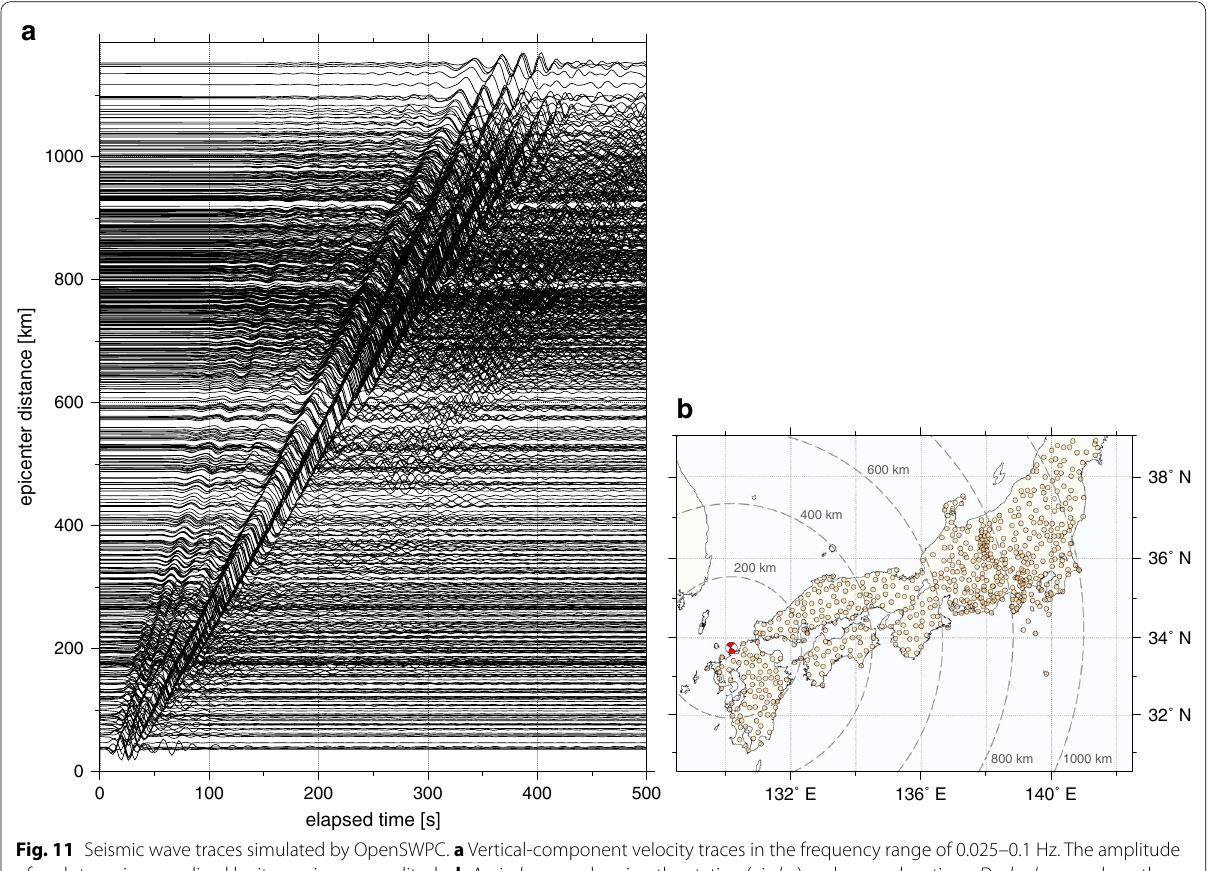
Fig. 11 Seismic wave traces simulated by OpenSWPC. a Vertical-component velocity traces in the frequency range of 0.025–0.1 Hz. The amplitude of each trace is normalized by its maximum amplitude. b An index map showing the station ( circles ) and source locations. Dashed curves show the iso-distance contour at every 200 km from the